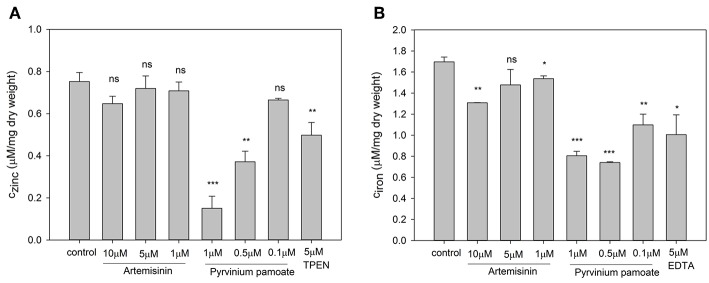
Candida albicans cultures were adjusted to a cell density OD600 = 0.01 and grown for 16 h in YNB with indicated compound concentrations and total cellular (A) zinc and (B) iron content was measure via ICP-OES. The values are the means ± SD of at least 2 independent experiments with 2 technical replicates. Changes of total metal content was compared to control conditions and p-values were calculate by unpaired, two tailed t-test (ns p > 0.05, *p ≤ 0.01, **p ≤ 0.001, ***p < 0.001).